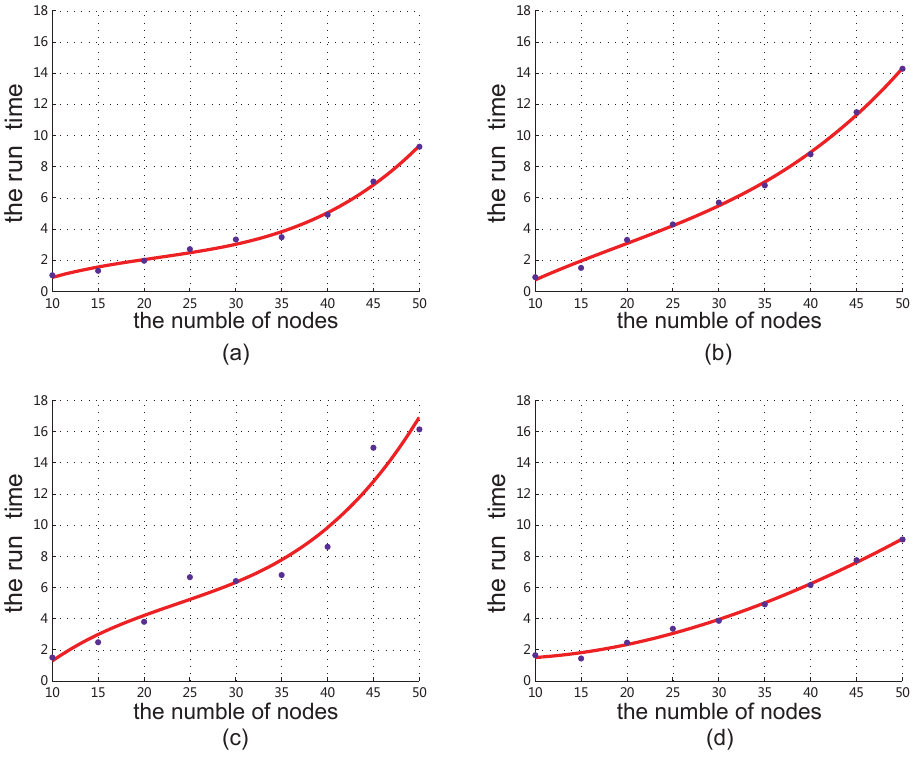
Figure 9. The fitting curve for the number of the nodes and the actual run-time ( a ) 2 base stations. ( b ) 3 base stations. ( c ) 4 base stations. ( d ) 5 base